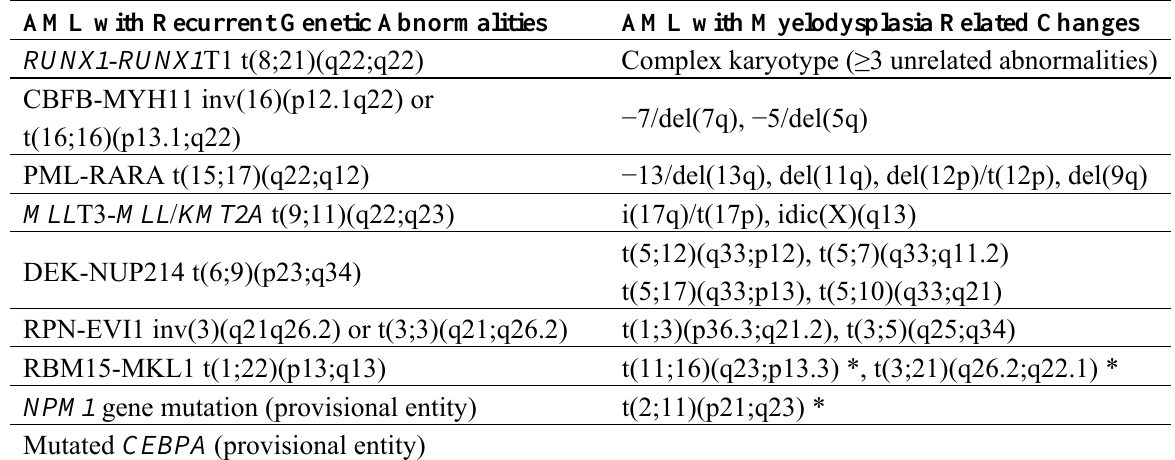
Table 1. Genetic abnormalities that affect acute myeloid leukemia (AML) classification. AML with Recurrent Genetic Abnormalities AML with Myelodysplasia Related Changes Complex karyotype ( ≥ 3 unrelated abnormalities)